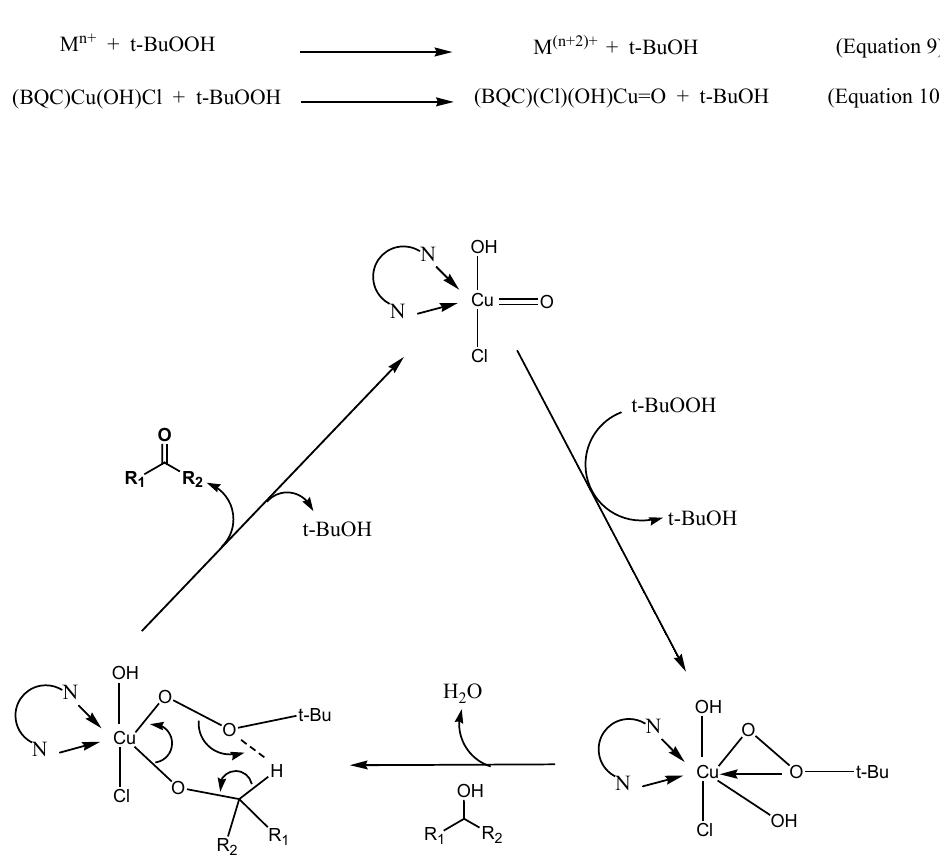
Scheme 4: Mechanism for the oxidation of benzylic alcohols to aromatic